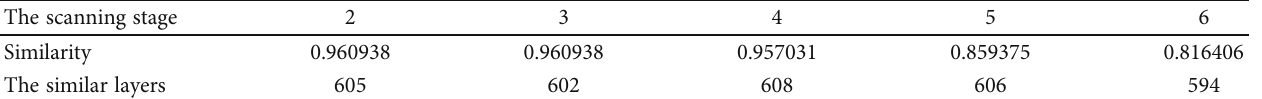
Table 3: The similar layers in each scanning stage.